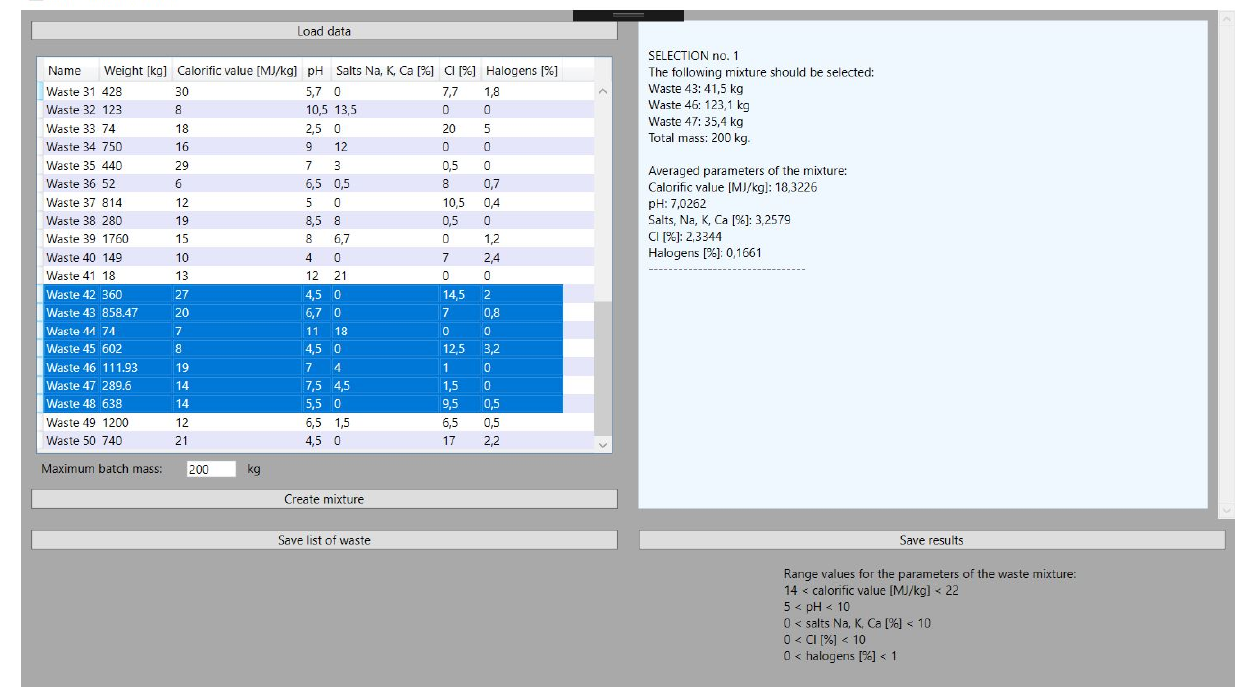
Figure 4. Results of the first received batch mixture.